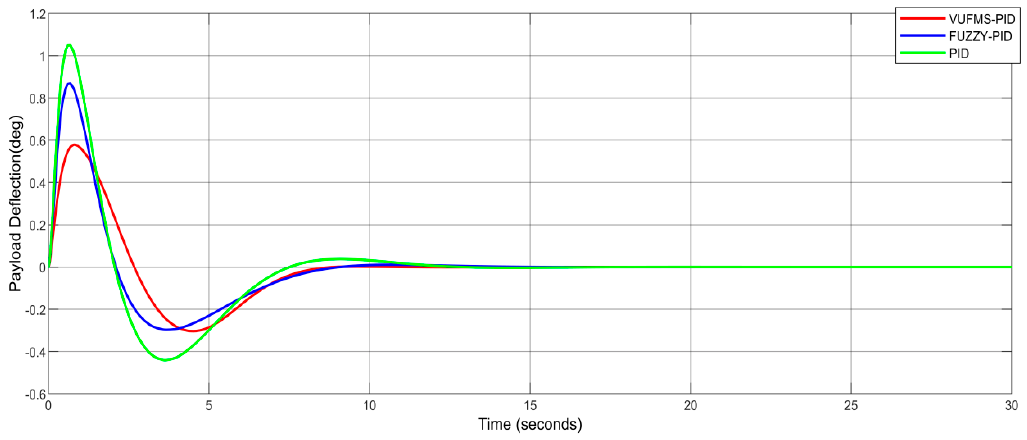
Figure 9. Payload’s swing angle ( θ ) using VUFMS-PID, FUZZY-PID and PID controller under working condition 1.